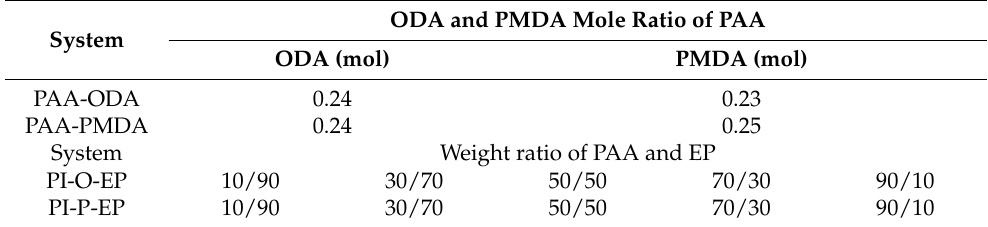
Table 1. Designed compositions of PI-O-EP and PI-P-EP composite copolymer. ODA and PMDA Mole Ratio of PAA System ODA